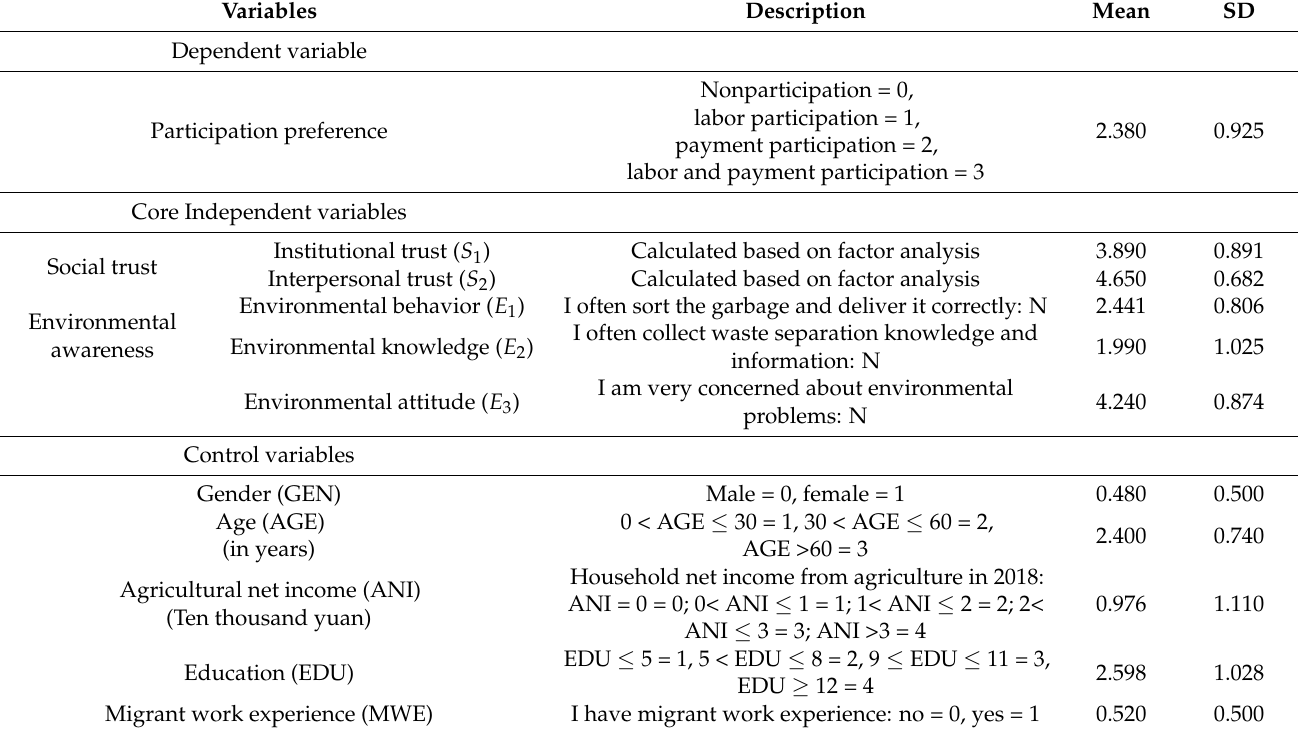
Table 2. Variables included in the multinomial logit model and coding of